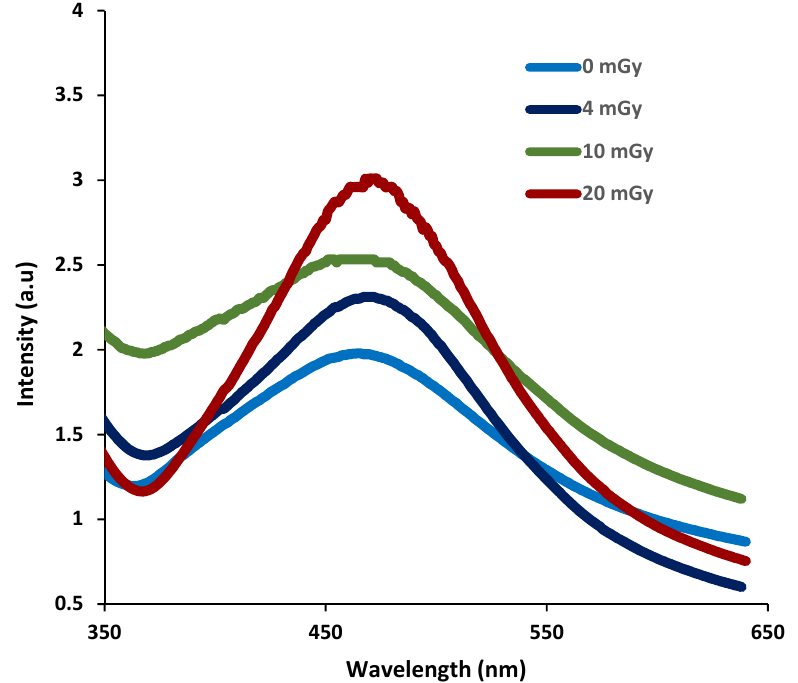
Figure 3. UV-Vis spectra of PVA/Ag + /NBT nanocomposite films before and after exposure to increased X-ray doses.